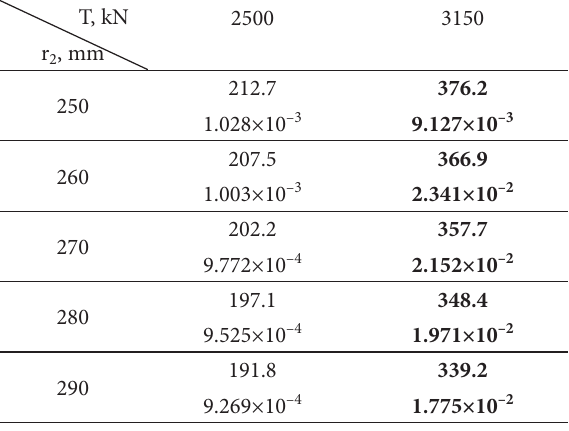
change by two planes (Fig. 3 b).